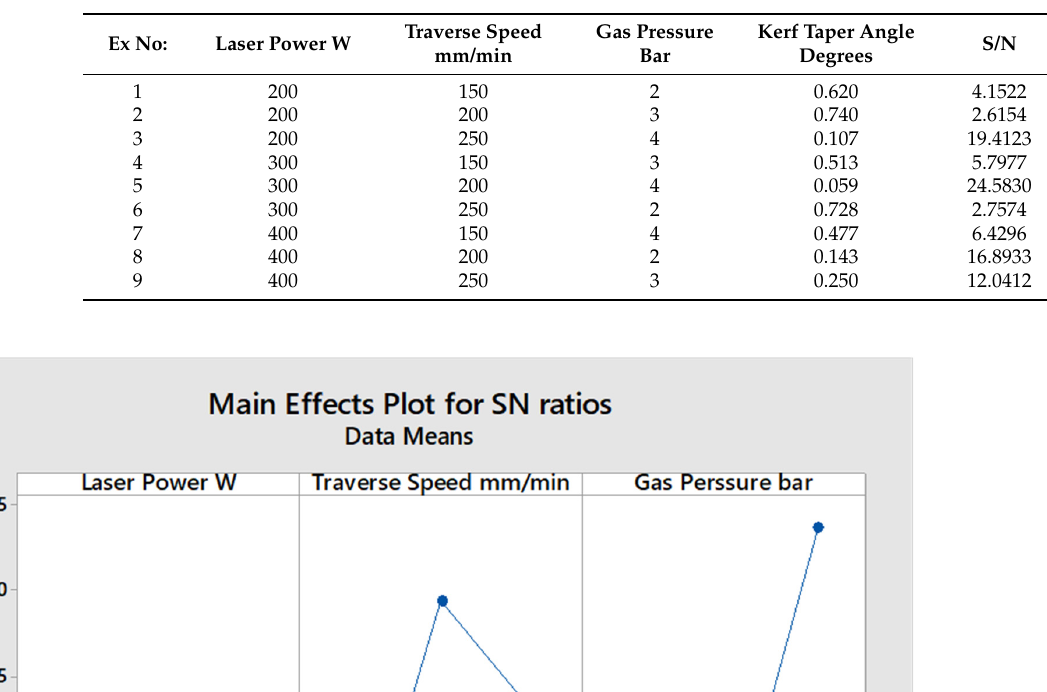
Table 7. L9 array of input parameter levels with measured Kerf taper angle θ ° in degrees and cal- culated signal-to-noise (S/N) ratio based on the Taguchi method for 2 mm specimen thickness.